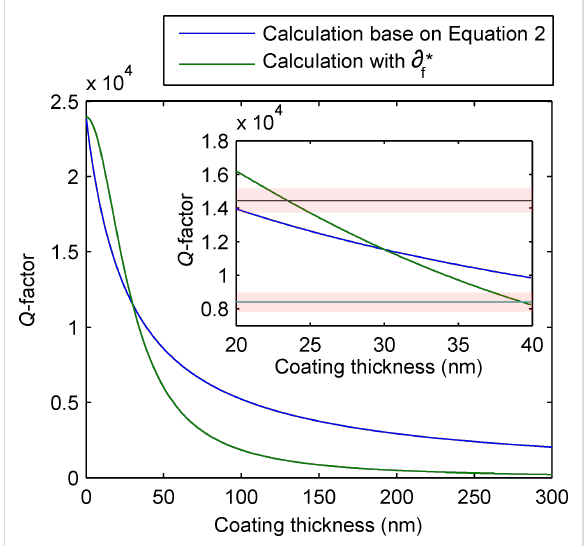
Figure 5: Calculation of the change of Q -factor for a fully coated NCLR cantilever with different coating thicknesses. Blue shows the predicted value according to Equation 2. Green shows the predicted Q -factor value with the added term. The inset shows a zoom to 20–40 nm. The mean measured Q -factor for two sets of NCLR with a coating thickness difference of 16 nm are plotted as a horizontal line with stan- dard error by red bands.